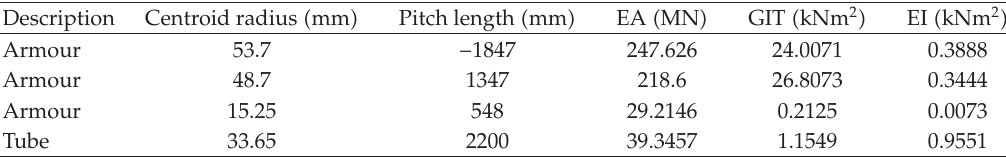
Table 12: Umbilical 9